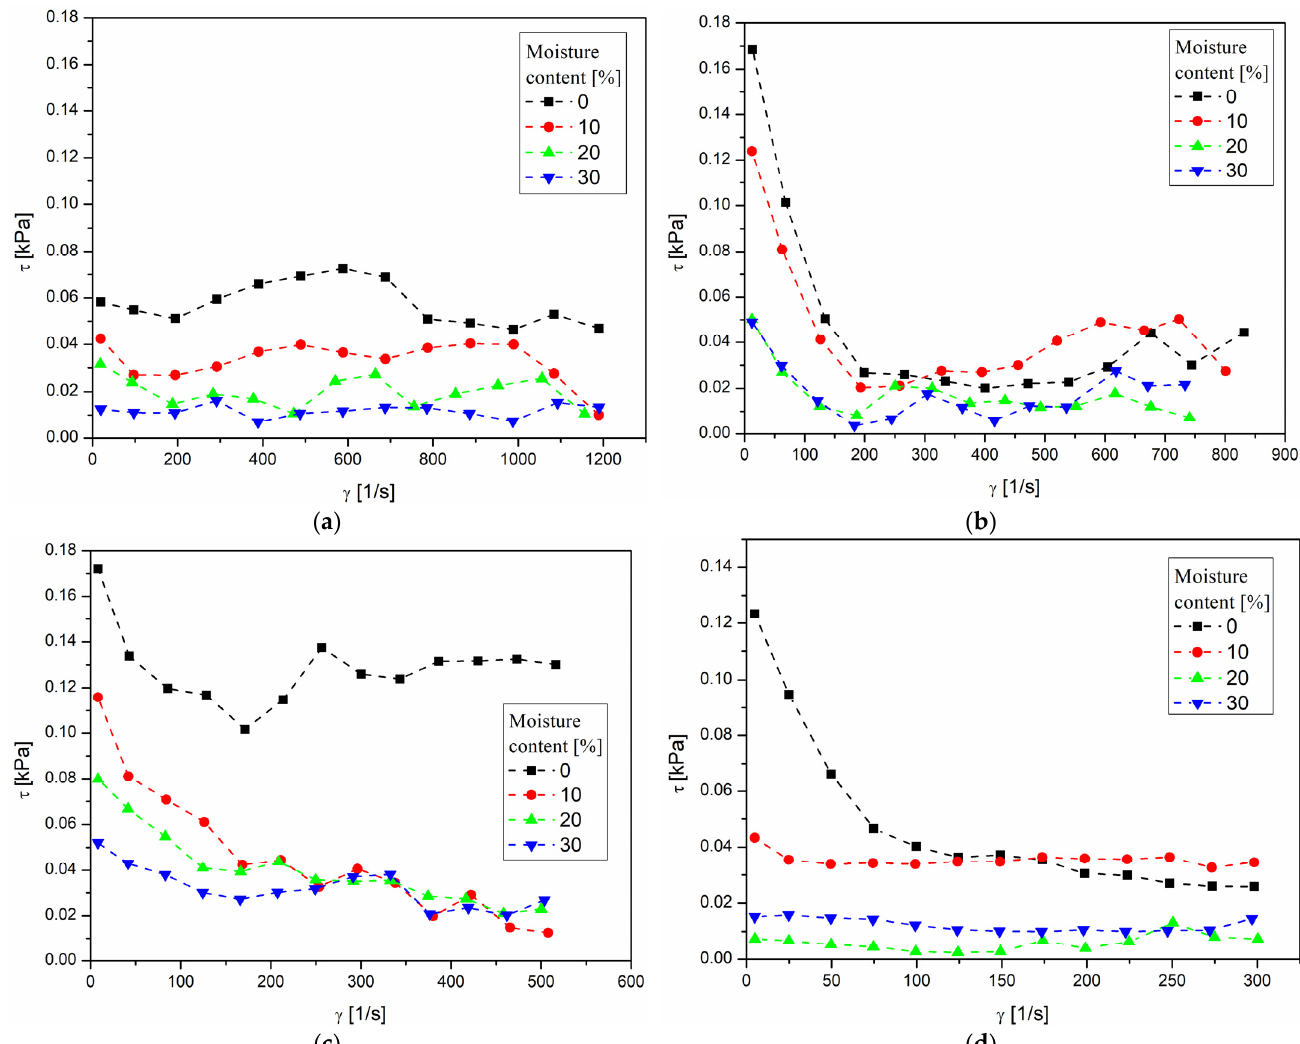
Figure 11. The influence of moisture content and shear rate γ ̇ on shear stress τ for: ( a ) mixture of HC 95%, MBM 5%; ( b ) mixture of HC 70%, MBM 30%; ( c ) mixture of HC 40%, MBM 60%; ( d ) MBM.